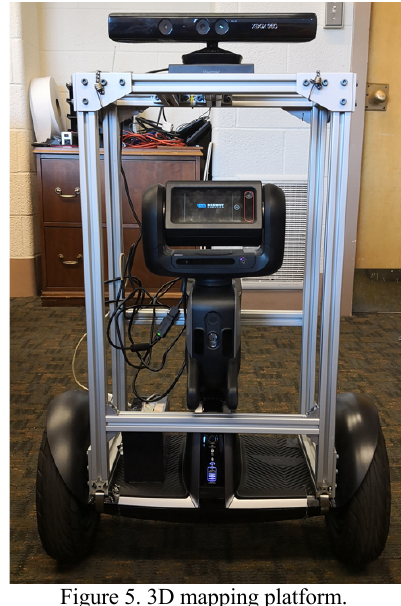
Figure 5. 3D mapping platform. After optimizing and noise filtering, the 3D indoor map dataset is integrated with the Wi-Fi radio map by (1) sampling and storing 5 RGB images from key frames for each cell with an average 0.6m interval between images, (2) the depth maps for each stored images are made with the registered and optimized 3D scans within 8 m range from the camera location, see Figure 6, (3) in order to reduce the calculation cost for the final step in InLoc, the 3D model of the floor is segmented and stored in each cell. The length of segments varies from 6m to